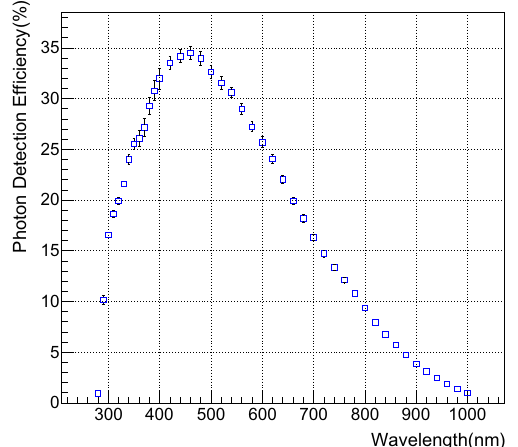
Fig. 3 PDE vs. wavelength characteristic of five Hamamatsu S14466 SiPM samples. The blue square is the mean value of PDE of the sam- ples, and the error bar is the RMS value of PDE of the samples. The data were provided by